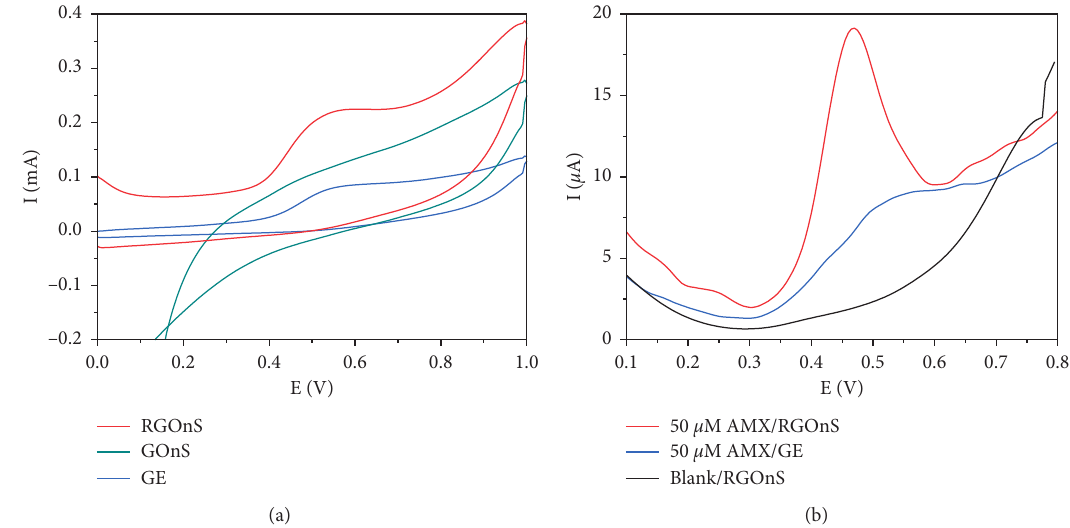
Figure 4: Cyclic voltammograms in 500 µ M AMX solution at a scan rate of 50mV/s (a) and square wave voltammograms in 50 µ M AMX solution with 120s accumulation (b) of studied electrodes. The electrolyte is 0.1 M PBS of pH